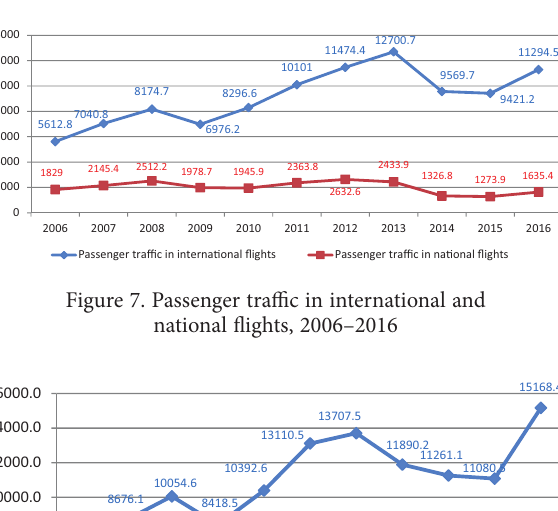
Figure 5. Number of Ukrainian airlines that carried out